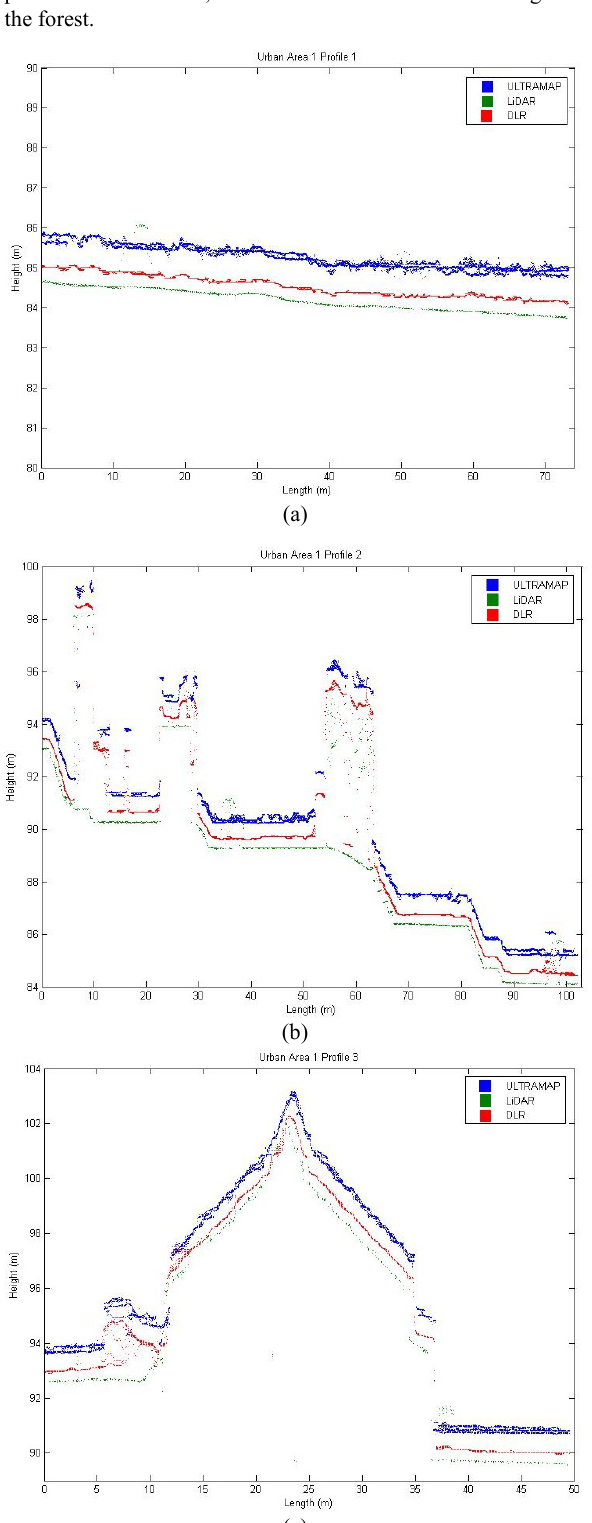
Figure 6. DSM profiles at flat road surface (a), inclined terrain including tree (b) and build up area